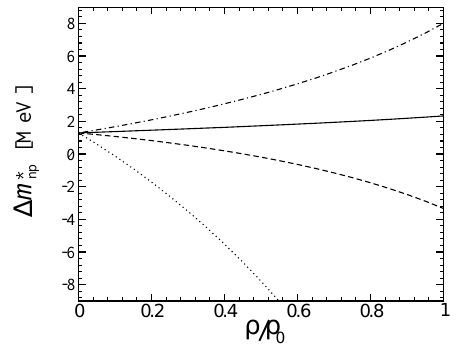
Fig. 8. Density dependence of the total neutron-proton mass dif- ference ∆ m ∗ in nuclear matter. The axes and curves are defined np as in Fig. 6. Figure from Ref.